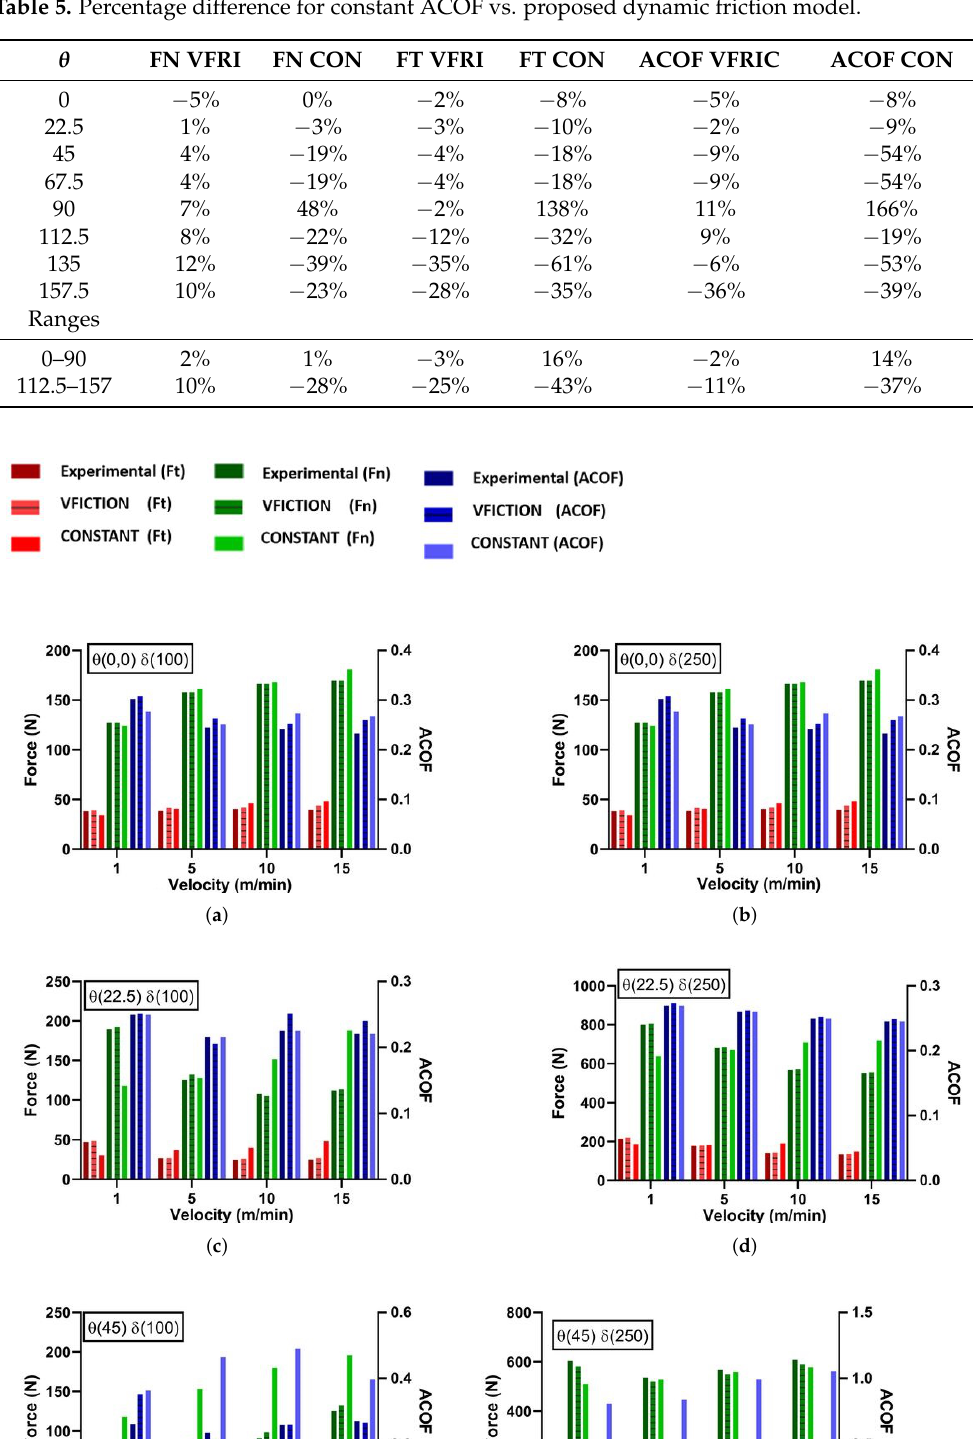
Table 5. Percentage difference for constant ACOF vs. proposed dynamic friction model.